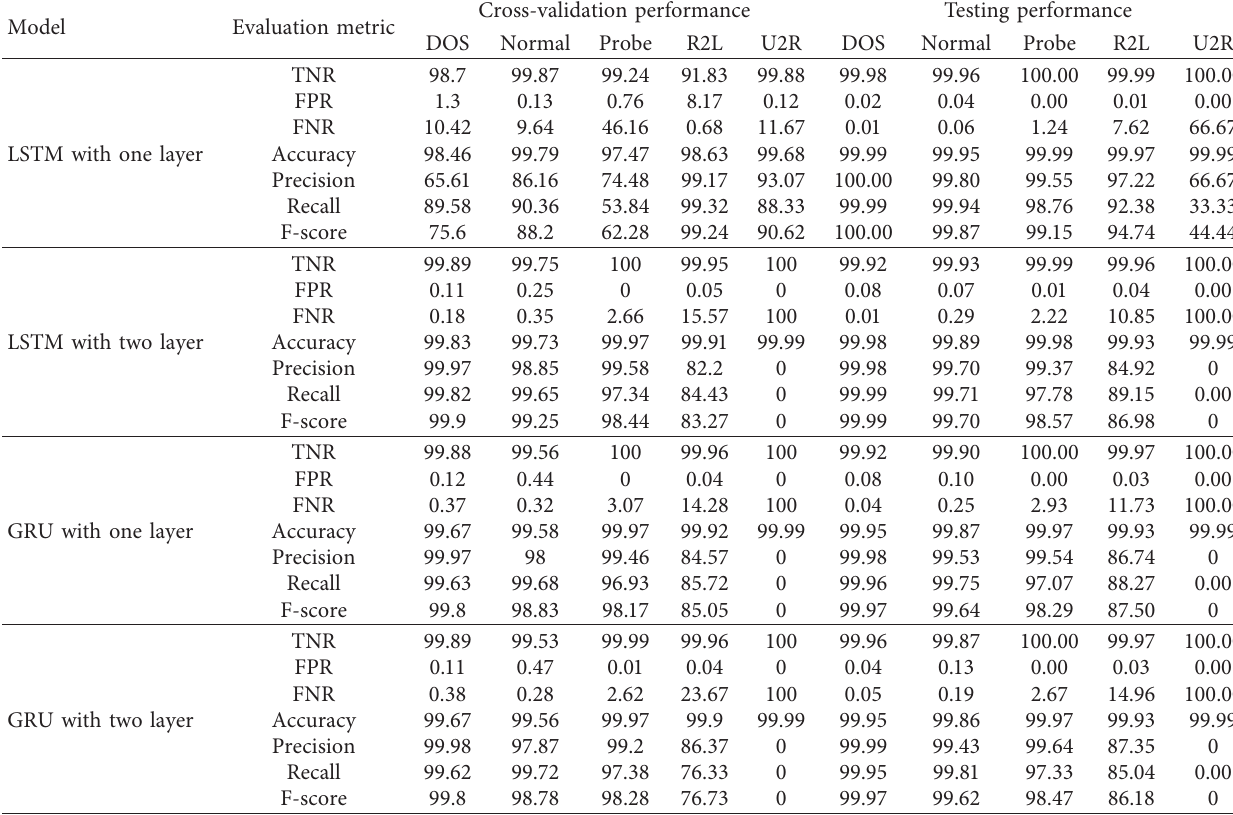
Table 16: The performance of deep learning for KDD dataset using LSTM and GRU with all features. Cross-validation Model Evaluation metric